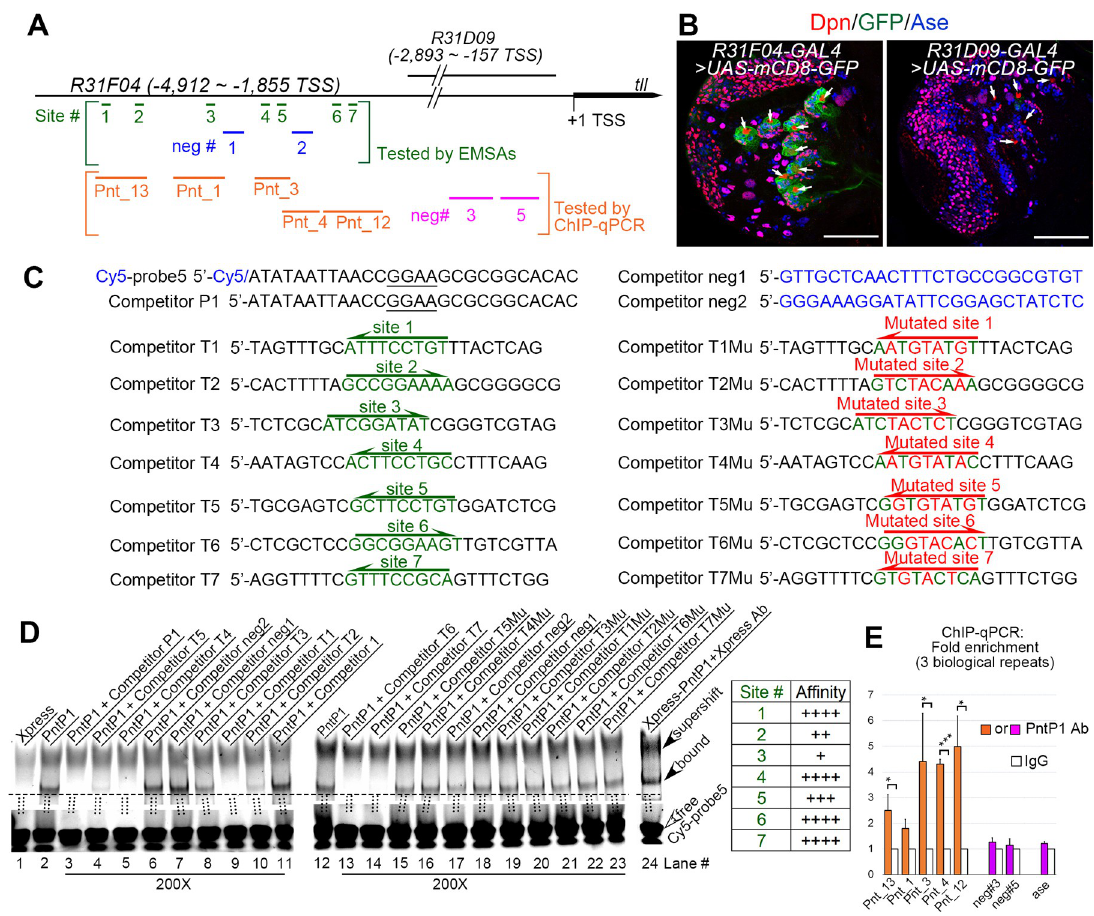
Fig 5. PntP1 directly binds to the tll enhancer in type II NBs. (A) A diagram of locations of putative PntP1 binding sites or negative control sites in the tll enhancer regions of R31F04 or R31D09 . Green lines and blue lines within square brackets indicate the PntP1 binding sites (sites #1–7) and the sequences (neg#1–2) lacking PntP1 binding sites, respectively, that are tested by EMSAs. Orange lines and magenta lines within the orange square brackets indicates DNA fragments with (Pnt_13, Pnt_1, Pnt_3, Pnt_4, Pnt_12) or without (neg#3, neg#5) corresponding PntP1 binding sites, respectively, that are tested by ChIP-qPCR. (B) GAL4 under the control of the tll enhancer subfragment R31F04 but not R31D09 specifically activates mCD8-GFP expression in type II NB lineages. White arrows point to type II NBs. Scale bars equal 50 μ m. (C) Sequences of competitors and probes used for EMSAs. Nucleotides in green indicate sequences of putative PntP1 binding motifs and nucleotides in red indicated mutations introduced into the putative PntP1 binding motifs. Underlined nucleotides in the Cy5-probe5 and the competitor P1 indicates the 5’-GGAA core sequence of the PntP1 binding motif. The direction of arrows indicates the orientations of the consensus 5’-GGAA/T-3’ core sequences. (D) EMSAs of the binding of Xpress-tagged PntP1 with Cy5-probe5 that contains a PntP1 binding motif from the erm enhancer fragment R9D11 and its competition by indicated competitors that contains corresponding wild type or mutated putative PntP1 binding motifs. Specific binding between Xpress-PntP1 and Cy5-probe5 is detected in lanes #2 and #12 and is verified by the presence of a super-shifted band in the presence of the Xpress antibody (lane #24) and the competition by the cold probe (competitor P1) (lane #3). Competitors that contain the wild type PntP1 binding sites (competitors T1-T7, corresponding to lanes #4–5, #8–10, and #13–14) can all compete with the Cy5-probe5 for the binding with Xpress- PntP1 to a various of degrees, but the competitors that contain mutated PntP1 binding motifs (competitors T1Mu-T7Mu, corresponding to lanes #15–16, and #19–23) or no PntP1 binding motifs (competitors neg1 and neg2 or the competitor 1 that contains the sequence from the kr enhancer, corresponding to lanes #6–7, #11, and #17–18) cannot. The relative binding affinity of the seven putative PntP1 binding site is summarized in the table to the right. Open arrowheads point to free probes while filled arrowheads point to the bands of PntP1-Cy5-probe5 complexes or the super-shifted band of the Xpress Ab-PntP1-Cy5-probe5 complex. The ratio of the competitor to the probe is 200 for all competitors tested. (E) DNA fragments (Pnt_13, Pnt_1, Pnt_3, Pnt_4, Pnt_12) that contain corresponding predicted PntP1 binding sites are all pulled down by the anti-PntP1 antibody from larval brains in the ChIP-qPCR assays, but not the DNA fragments neg#3 or neg#5 from the R31D09 enhancer region or a DNA fragment from the ase enhancer that do not contain putative PntP1 binding sites. The quantification data represent the Mean ± SD of the fold changes normalized to IgG controls of three biological replicates. � , P < 0.05. ��� , P <